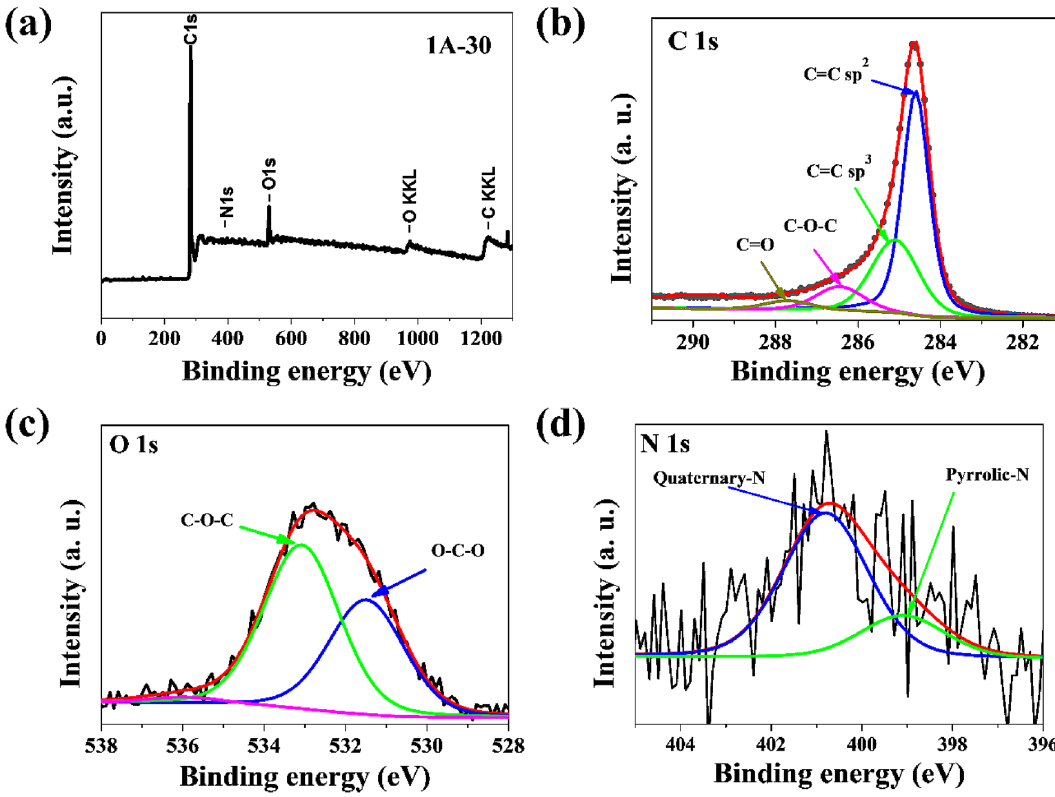
Figure 6. ( a ) XPS survey spectrum and high-resolution XPS spectra of ( b ) C1s, ( c ) O1s, ( d ) N1s for 1A-30 sample.